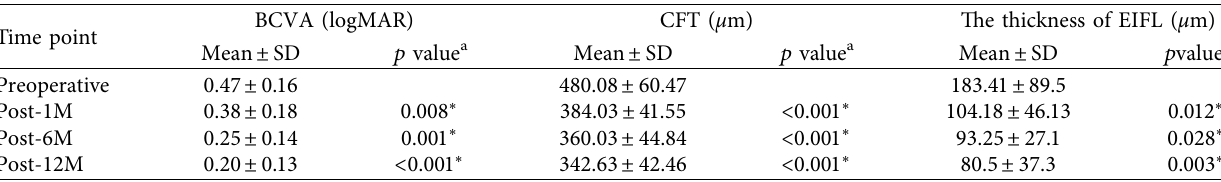
Table 2: Comparison of preoperative and postoperative BCVA, CFT, and the thickness of EIFL in patients with idiopathic epiretinal